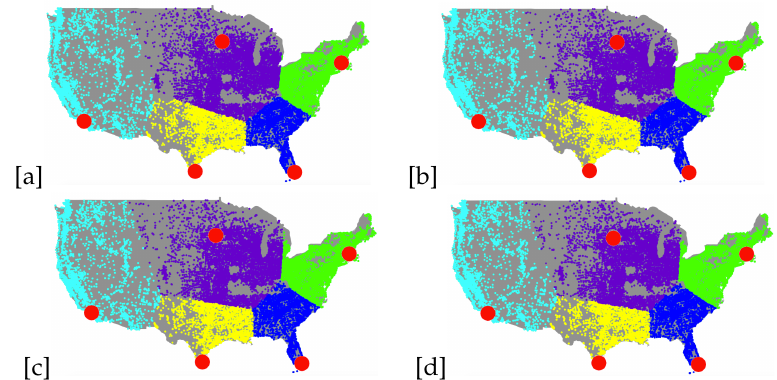
Figure 9. Clusters found for the complete schools dataset.